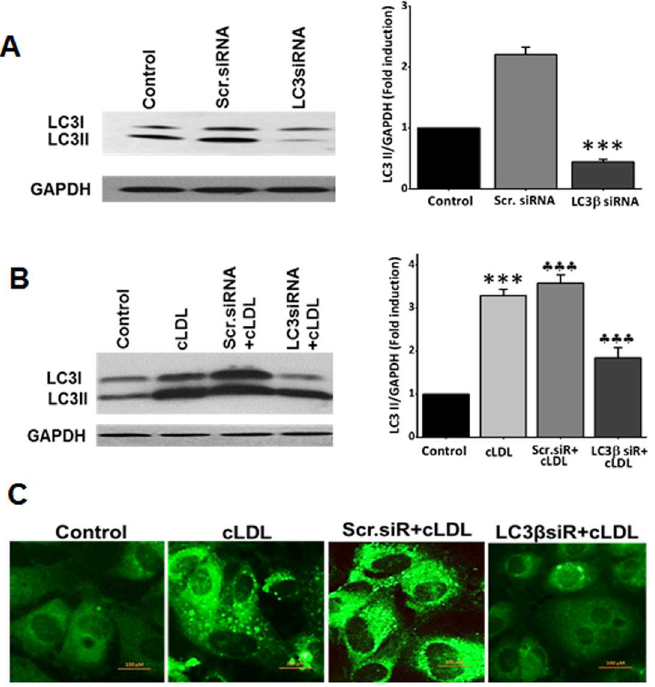
Fig 4. Effect of LC3 siRNA transfection on cLDL-induced autophagy. (A) A representative western blot in the left panel shows the efficacy of transfectionwith siRNA. HCAE cells transfected with LC3 β siRNAor scr. siRNA for 48h and expressionof LC3 was determinedby western blots. GAPDH was used as a loading control for total cellularproteins. Histograms in the right panel shows the quantitative data (mean ± SD) for western blot analysisfrom three separate experiments ( *** p < 0.001comparedto control). (B) LC3 β /scr. siRNAs transfected or untransfected cells were treated with 100 μ g/mlof cLDL for 8h. A representative blot for western blots is shown in the left panel.Histograms in the right panel shows the quantitative data (mean ± SD) for western blot analysisfrom three separate experiments. GAPDH was used as a loadingcontrol for total cellularproteins( *** p < 0.001compared to control, †† p < 0.001comparedto cLDL treated cells). (C) Effect of LC3 β siRNA on cLDL-induced autophagyby immunostaining. Representative images of LC3 immunostaining from three separate experiments for LC3 β /scr. siRNAs transfected, cLDL treated and untreatedcells are shown in the